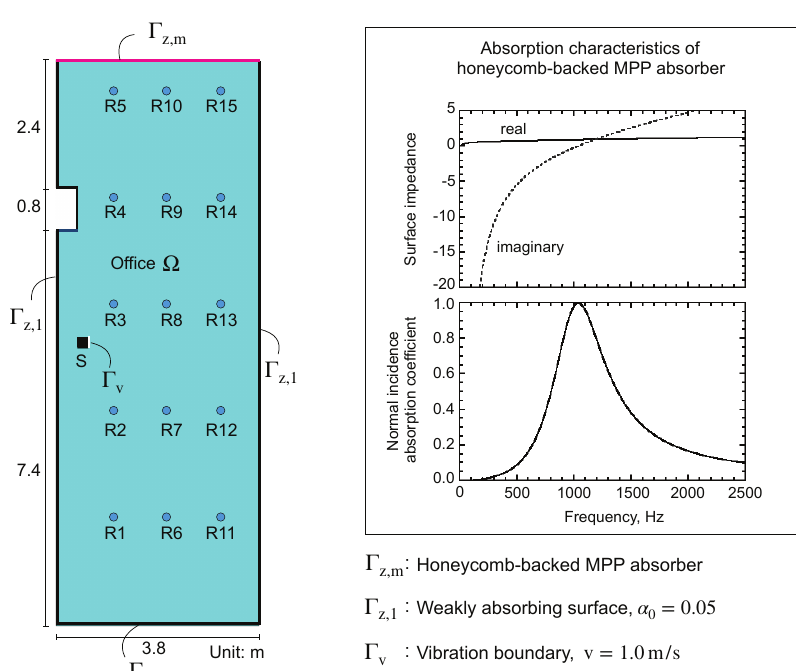
Figure 2. Single-room model including a vibration boundary, and impedance boundaries of weakly absorbing surfaces and honeycomb-backed microperforated panel absorbers: S and R respectively represent sound source and